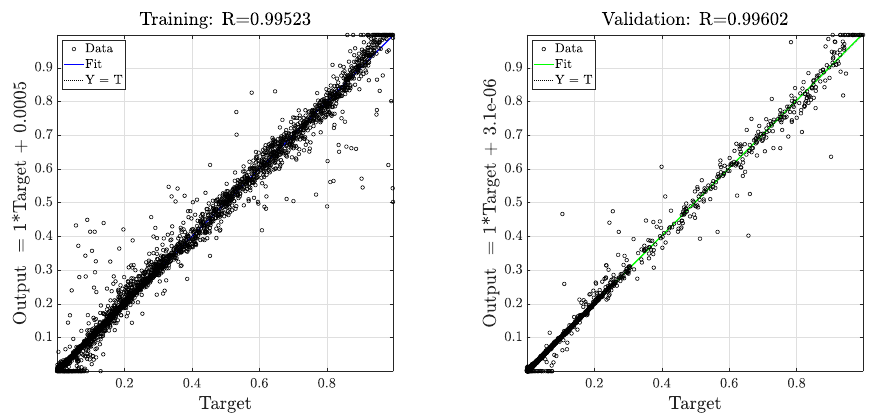
Figure 13. Correlation between targets (i.e., expected outputs) and actual outputs of the network for sampling mode 3, 18 neurons and trainlm algorithm, for training and validation datasets